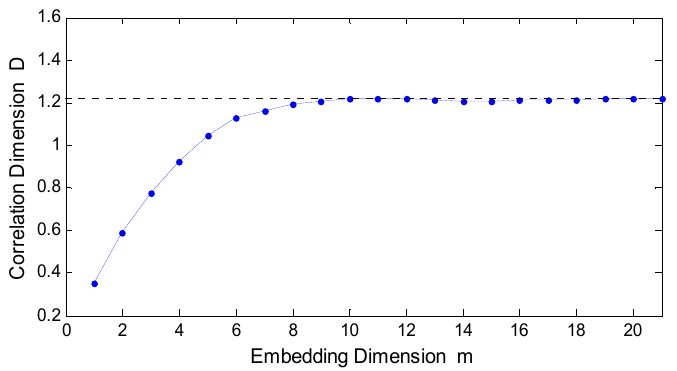
Figure 6. The curves of D over m for the BOD dataset.